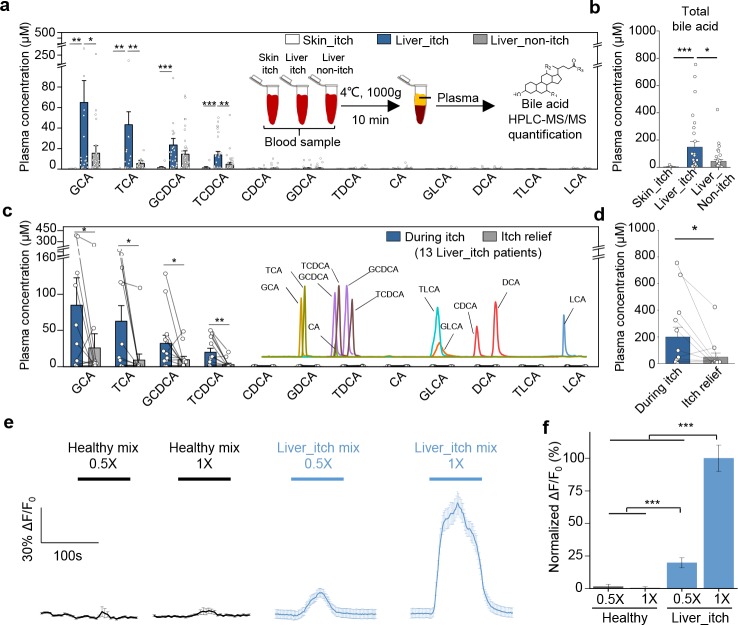
Elevated bile acids are correlated with the occurrence of itch among patients with liver disease and are sufficient to activate MRGPRX4.(a–b) Summary of individual bile acid levels (a) and total bile acid levels (b), the sum of the 12 bile acids shown in a) in itchy patients with liver diseases (Liver_itch, n = 27), non-itchy patients liver with diseases, (Liver_non-itch, n = 36), and itchy patients with dermatic diseases (Skin_itch, n = 8). The plasma bile acid levels were measured using HPLC-MS/MS (inset). (c–d) Summary of individual bile acid levels (c) and total bile acid levels (d), the sum of the 12 bile acids shown in c) in 13 patients with liver diseases during itch and after itch relief. The inset shows the separation of standard bile acids by HPLC-MS/MS. (e–f) Left, Ca2+ responses in MRGPRX4-expressing HEK293T cells induced by application of a mixture of artificial bile acids derived from itchy patients with liver diseases and healthy subjects. The Ca2+ signal was measured using Fluo-8 and was normalized to the signal measured using the 1x liver_itch mix. The summary data are shown in (f); n = 50 cells each. All error bars represent the s.e.m.. Student’s t-test, *p<0.05, **p<0.01, ***p<0.001.